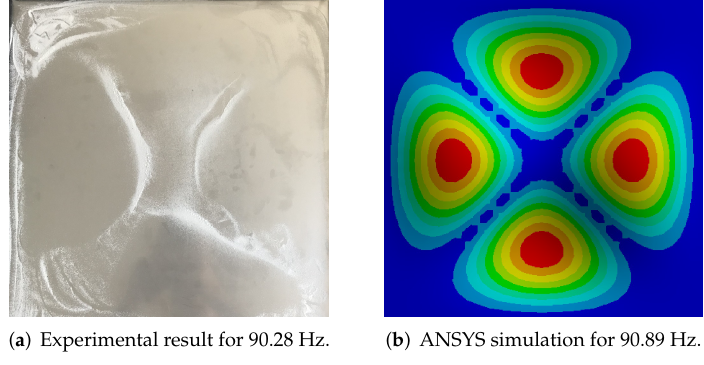
Figure 6. Selected